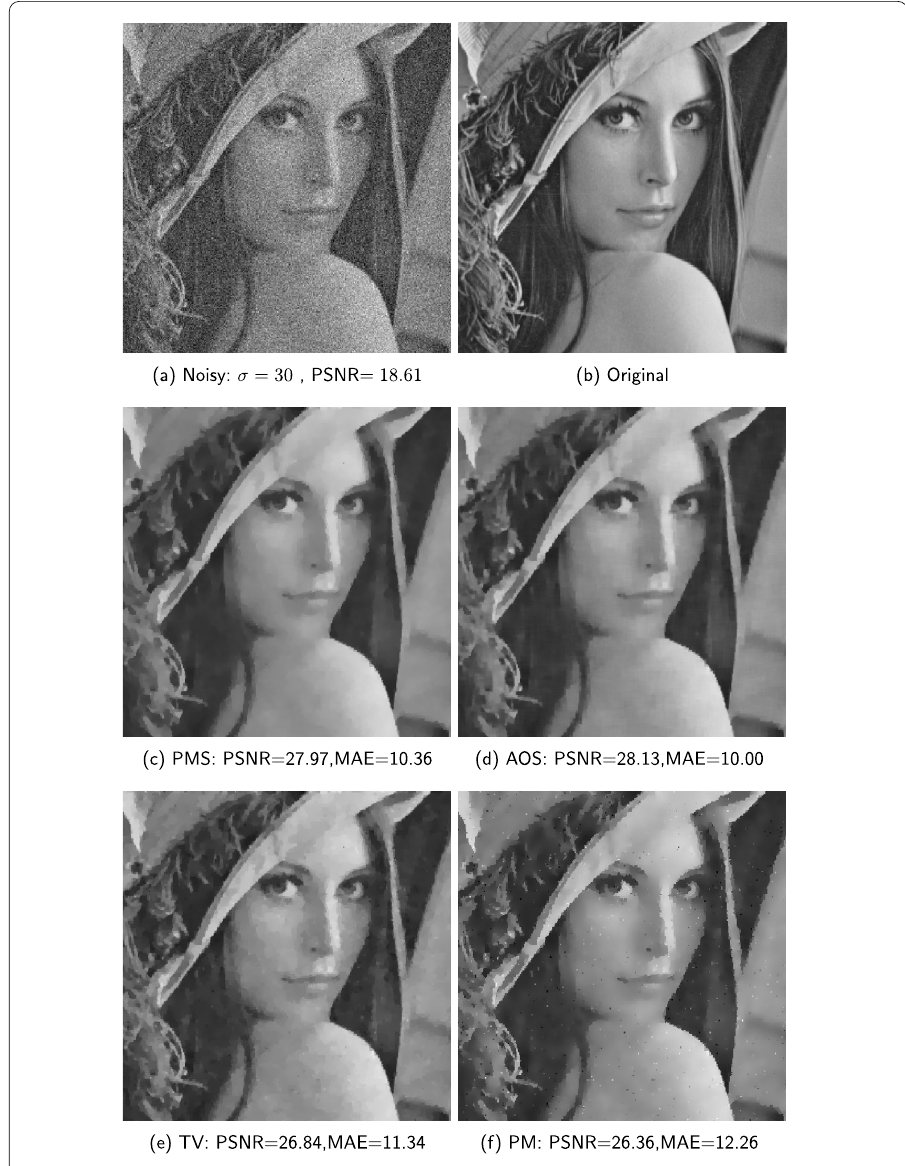
Figure 5 Lena image (300 × 300): ( a ) noisy image corrupted by Gaussian noise for σ = 30; ( b ) original image; ( c ) our algorithm by PMS, μ 1 = 0.5, μ 2 = 0.5, and τ = 0.2; ( d ) our algorithm by AOS, μ 1 = 0.9, μ 2 = 0.1, and τ = 2; ( e ) TV algorithm, τ = 0.2; and ( f ) PM algorithm, τ = 0.2 and K =